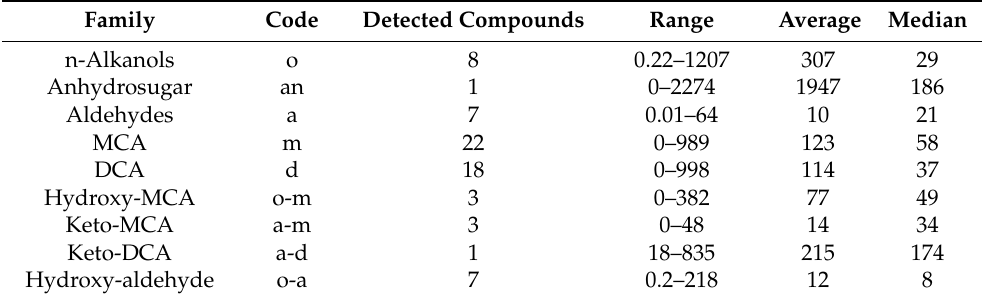
Table 2. Summary of 9 family compounds determined in fine PM. Range, average, and median concentrations in ng m − 3